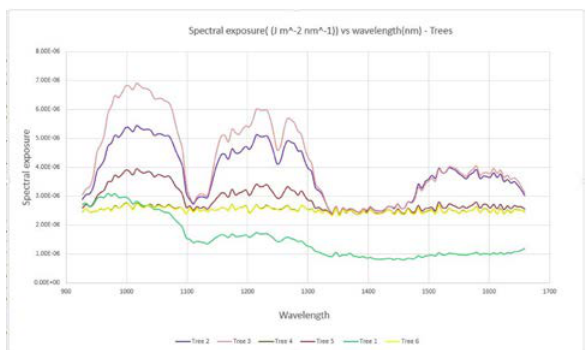
Figure 7. Spectral exposures of various